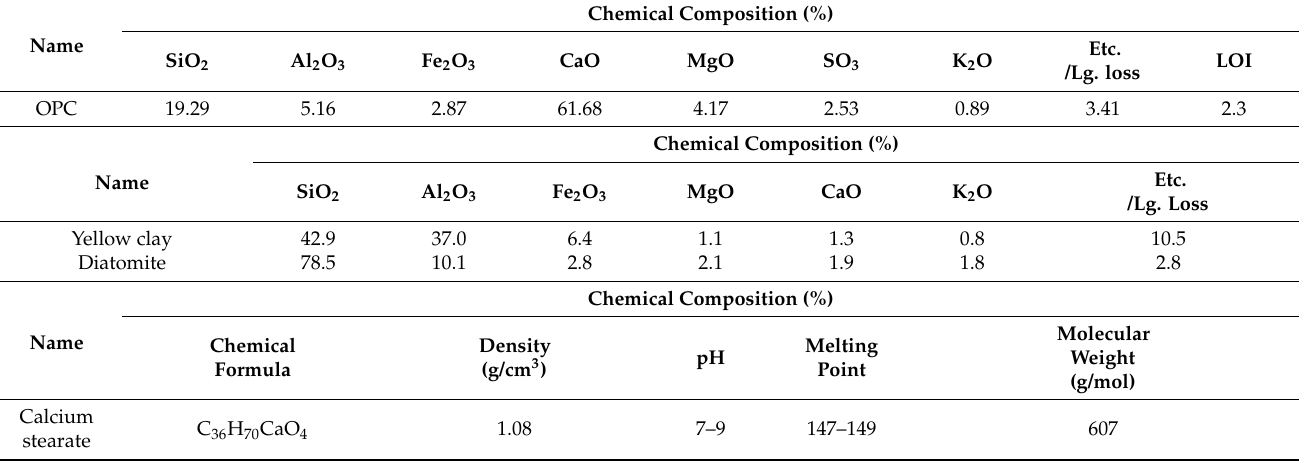
Table 1. Chemical composition of binder materials (OPC, Yellow clay, diatomite, calcium